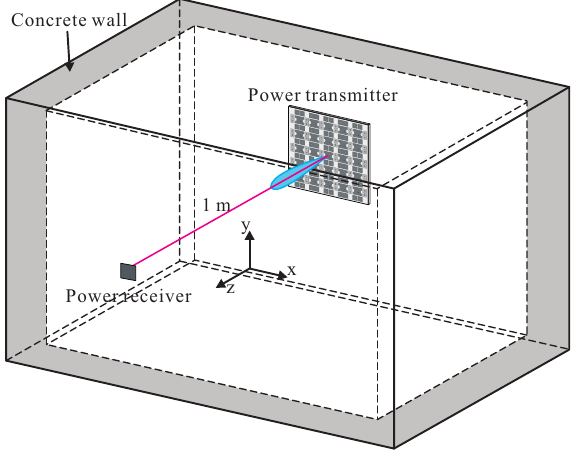
Figure 9. Simulation model for wireless power transmission.